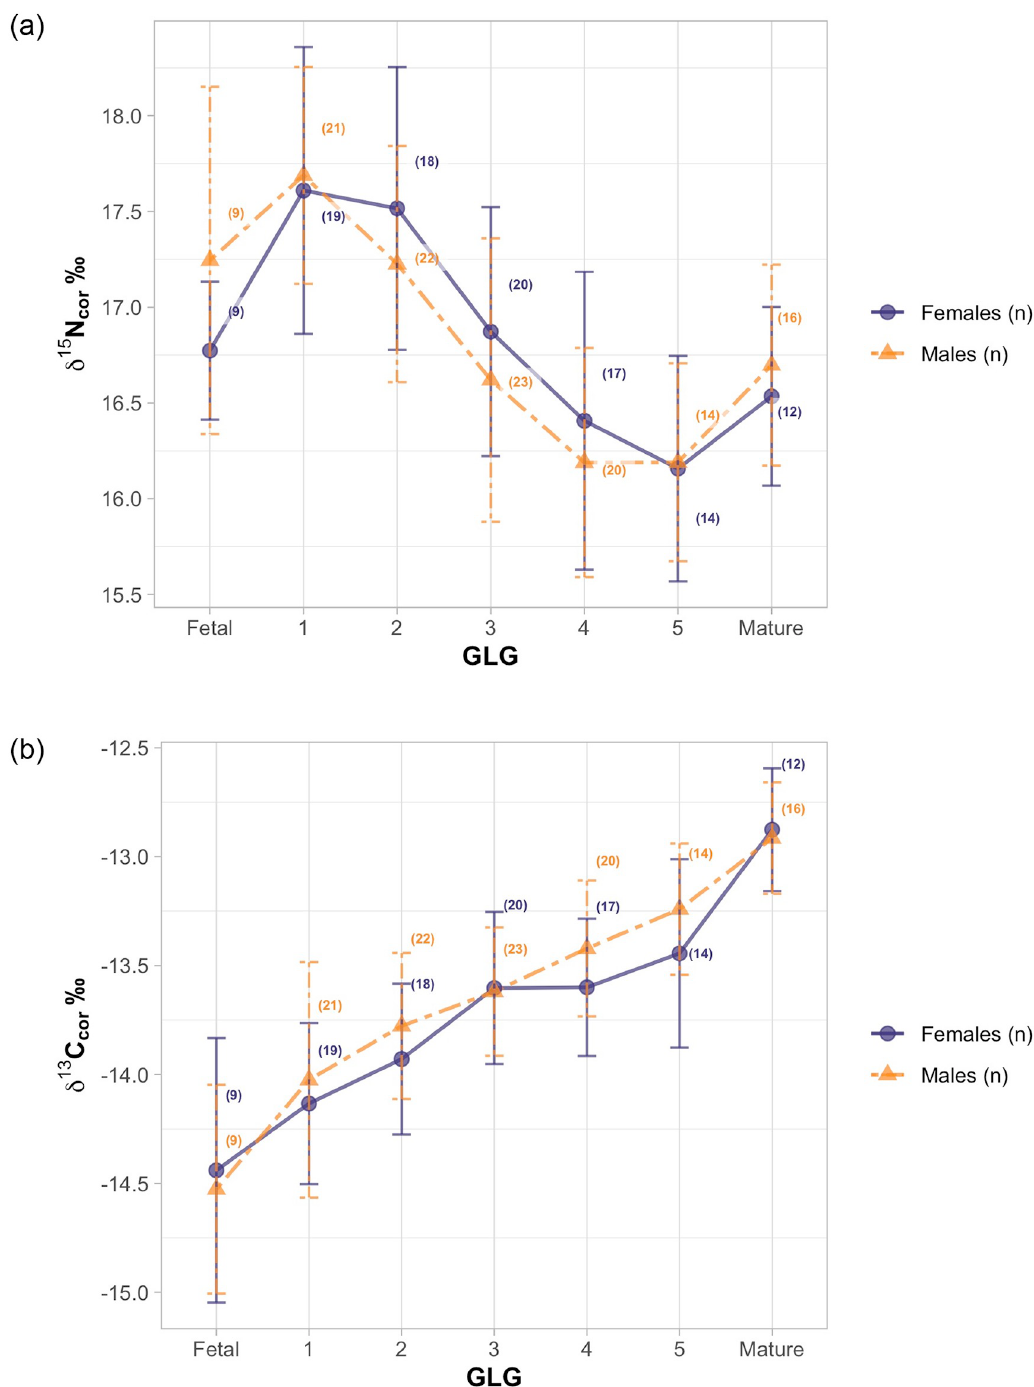
Fig 4. Ontogenetic trends in average (a) δ 15 N and (b) δ 13 C by sex. Females (N = 109 GLG samples) are purple points and males (N = 125 GLG samples) are orange triangles. Whisker bars represent standard deviation. Iceland and Labrador samples only.